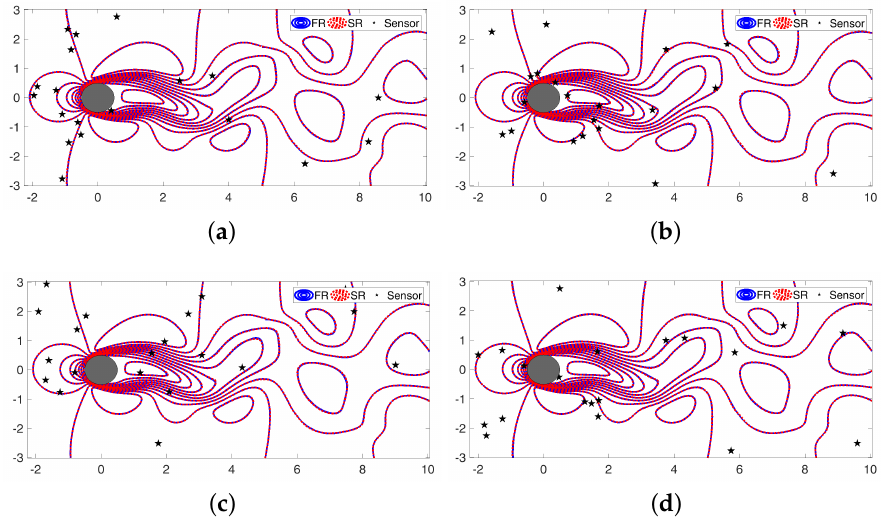
Figure 10. Comparison of POD-based SR and FR for different random sensor placement and P ∗ > K ∗ . Blue solid line: FR. Red dashed line: SR. Black stars: sensor locations. ( a ) Seed = 101 (at P ∗ = 10 and K ∗ = 5); ( b ) Seed = 102 (at P ∗ = 10 and K ∗ = 5); ( c ) Seed = 108 (at P ∗ = 10 and K ∗ = 5); and ( d ) Seed = 109 (at P ∗ = 10 and K ∗ =